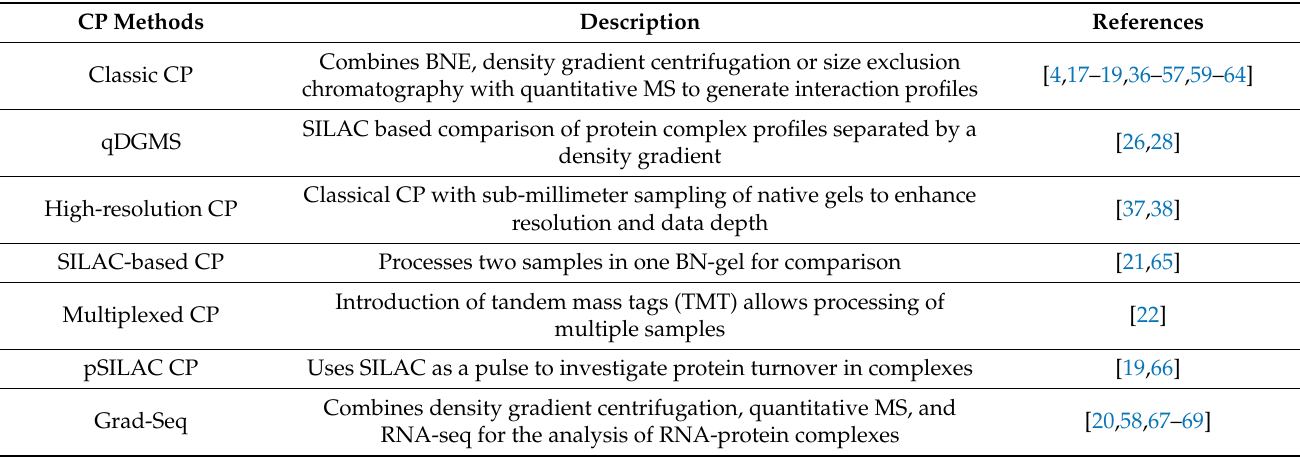
Table 1. Versions of CP methods to examine inventory of protein